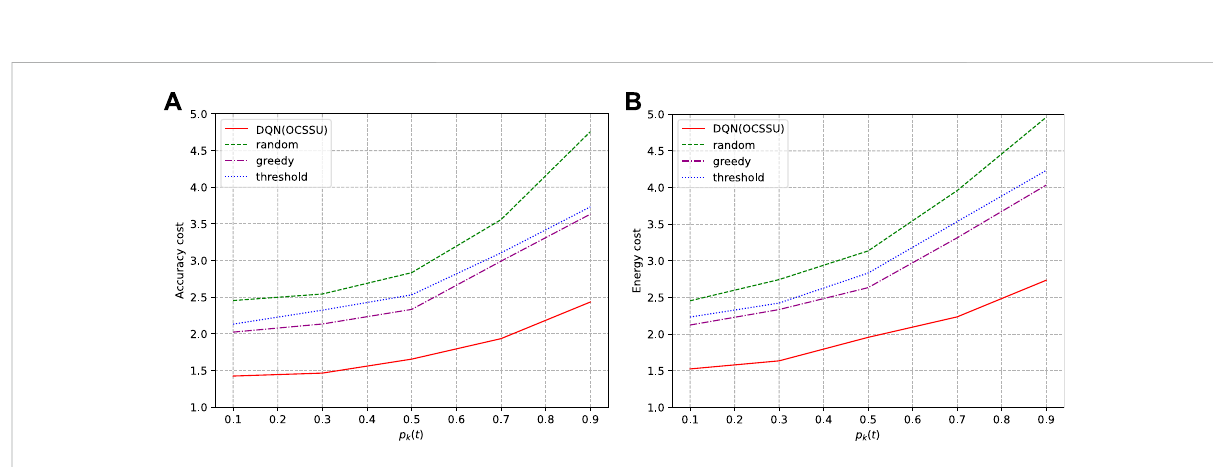
FIGURE 11 Effect of different user request frequencies on the proposed algorithm and baseline policies in terms of information accuracy cost and energy cost. (A) shows the average information accuracy cost and (B) shows the average energy cost.